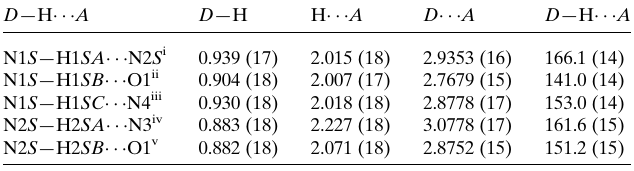
Table 1 Hydrogen-bond geometry (A˚ , (cid:4) ) for 1 .